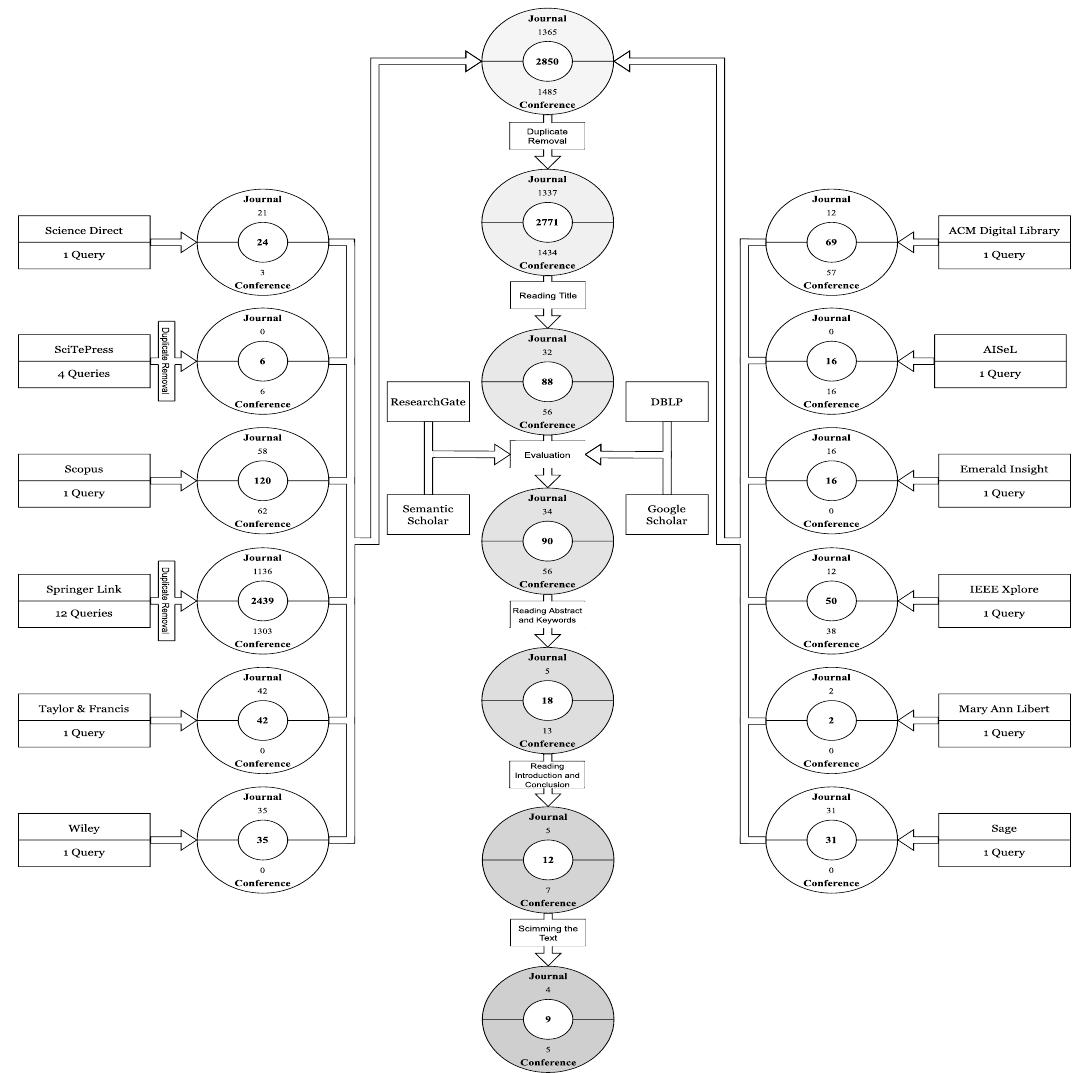
Figure 1. The Search